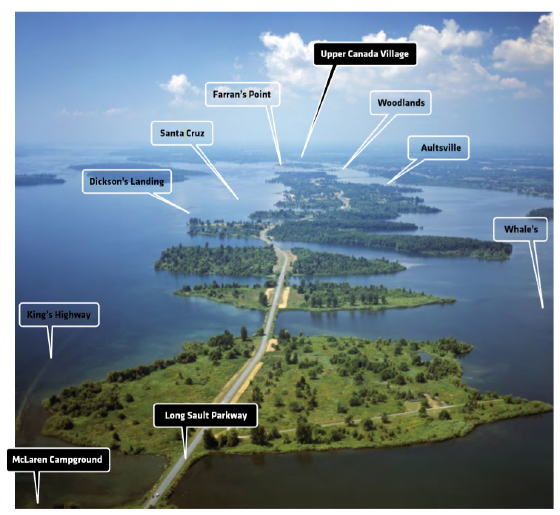
Figure 1. Image of